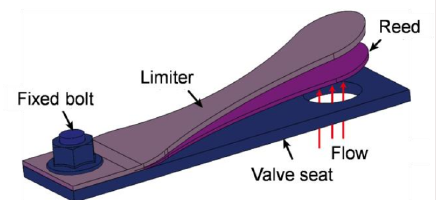
Figure 1. Schematic diagram of the typical reed